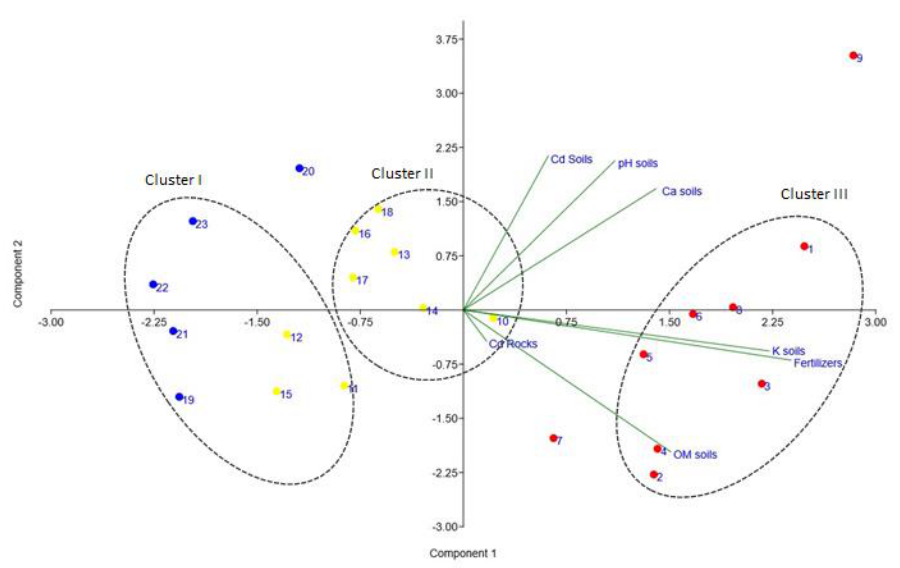
Figure 6. Principal component analysis including the main soil factors measured in the study soils. Clusters resulting from the paired-group analysis are overlaid. Farm 1 is indicated by red dots, Farm 2 by yellow dots and Farm 3 by blue dots; analysis carried out with PAST 4.07 [35].